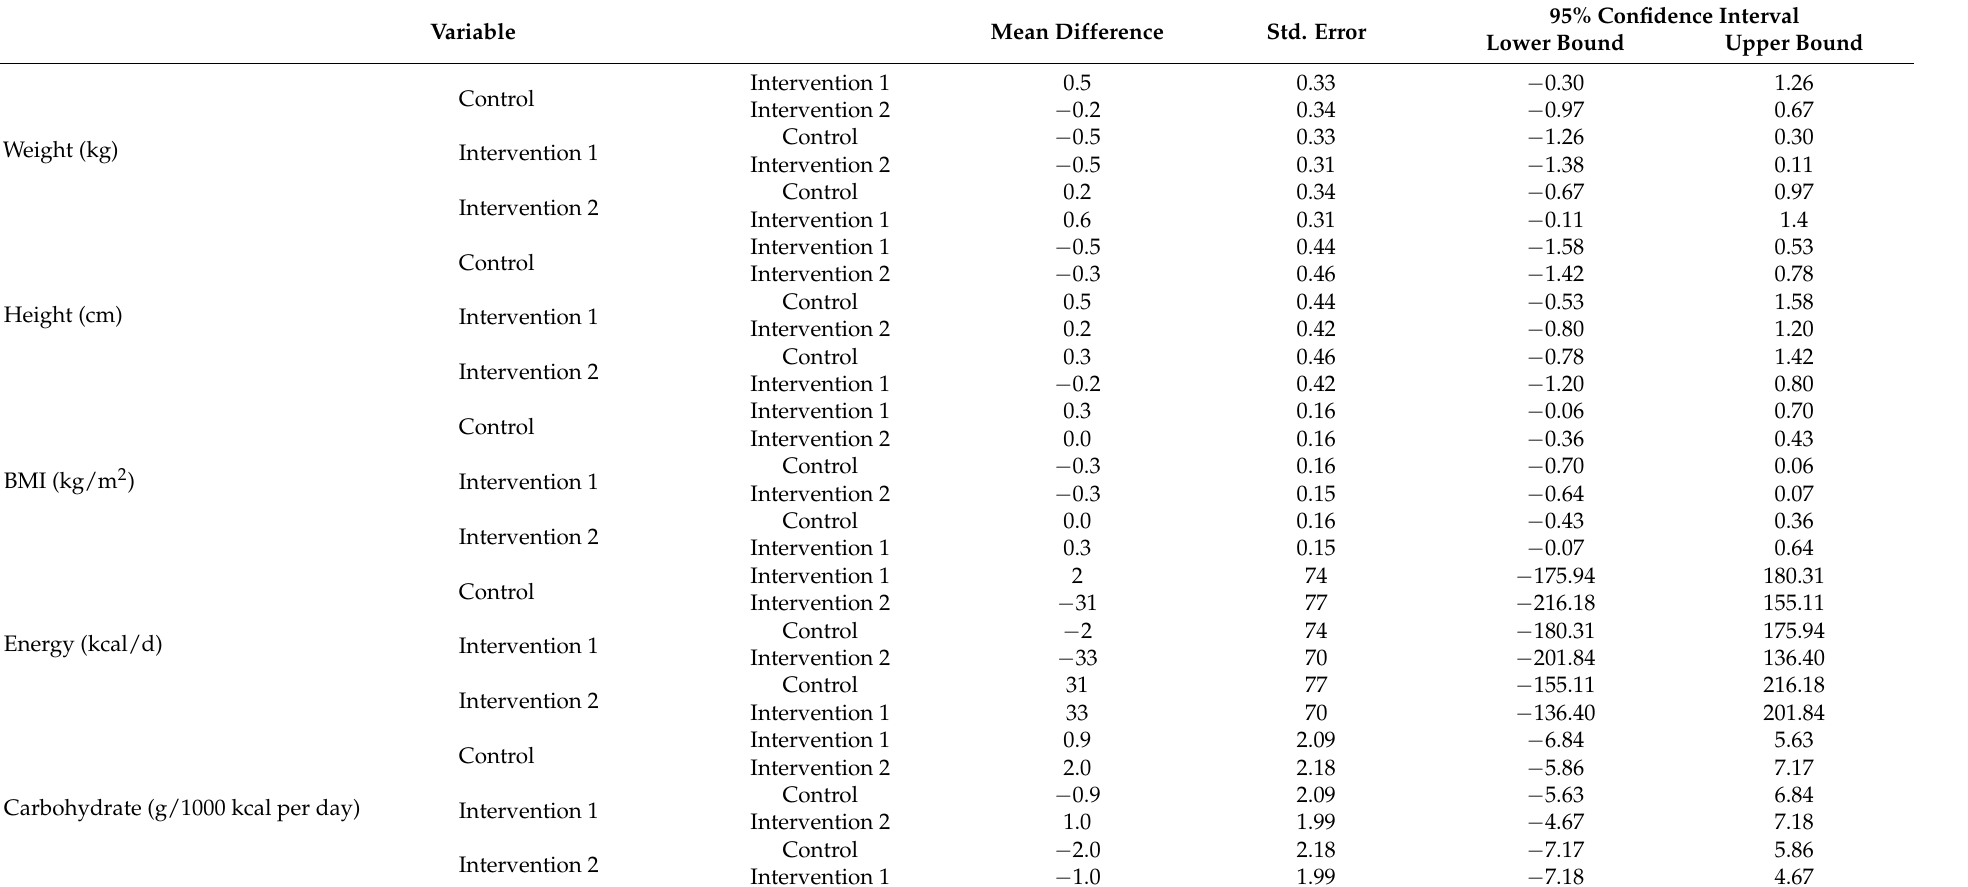
Table 3. Effects of intervention on anthropometry and dietary intake measures of MyHeART BEaT